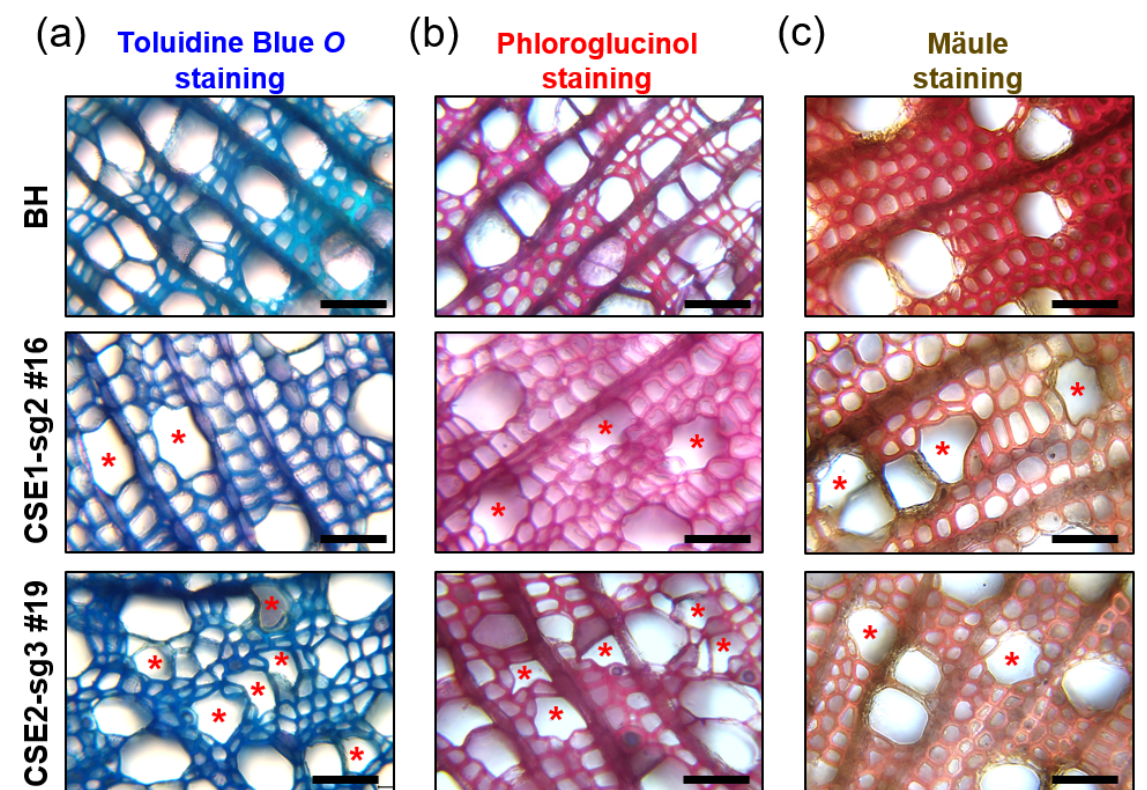
Figure 4. Transgenic CSE-CRISPR hybrid poplars have irregularly shaped xylem vessel cells. Stem anatomy of hybrid poplars (8-month-old LMO field grown) was assessed by ( a ) toluidine blue, ( b ) phloroglucinol-HCl, and ( c ) Mäule staining. Collapsed irregular vessels are marked with asterisks. Scale bars represent 50 µm.